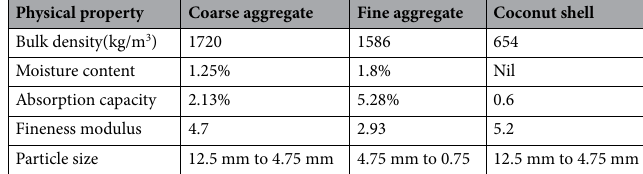
Table 3. Physical properties of coarse, fine and coconut shell aggregate.